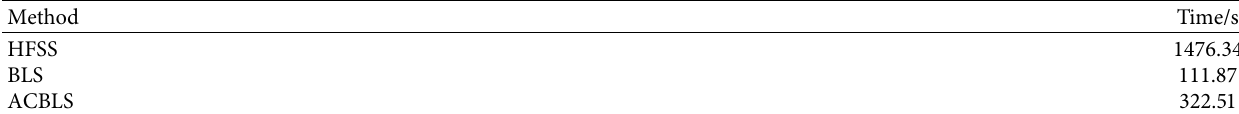
Table 9: Optimization times of the relevant methods.